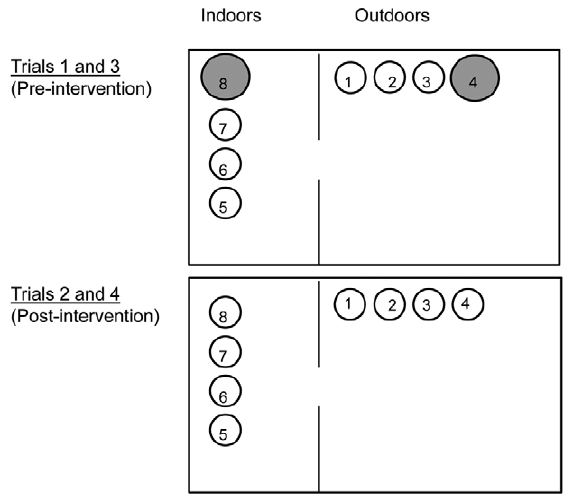
Figure 3. Diagram of oviposition sites within semi-field enclosure. Trials 1 and 3 were pre-intervention trials during which females were presented with two large unmanaged containers (grey circles) and six small manually filled containers (white circles). Trials 2 and 4 were post-intervention trials during which females had access to eight small manually filled containers. Containers 1–4 were located outside in the yard and containers 5–8 were inside the house. The windows were left open to allow free movement of mosquitoes indoors and outdoors. Containers are not drawn to scale with the house.